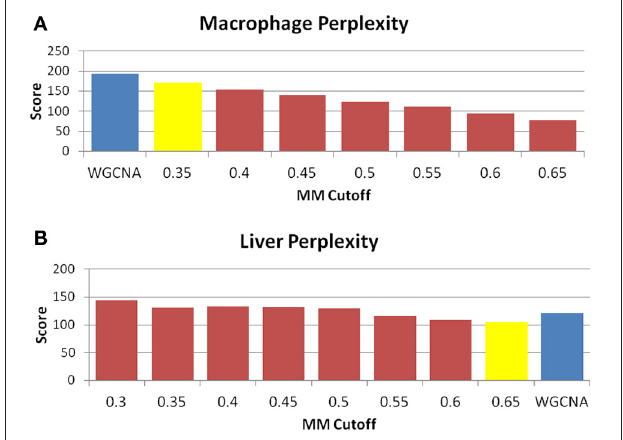
FIGURE 7 | MICA has higher average GO enrichment in the macrophage dataset. Average GO enrichments for modules derived from (A) macrophage and (B) liver datasets. The blue bar is the score received by WGCNA, while the yellow bar is the score returned for MICA at the optimal MM cutoff. A higher score is more desirable, and we observe improved average GO enrichment for MICA in the macrophage data, and improved average GO enrichment for WGCNA in the liver